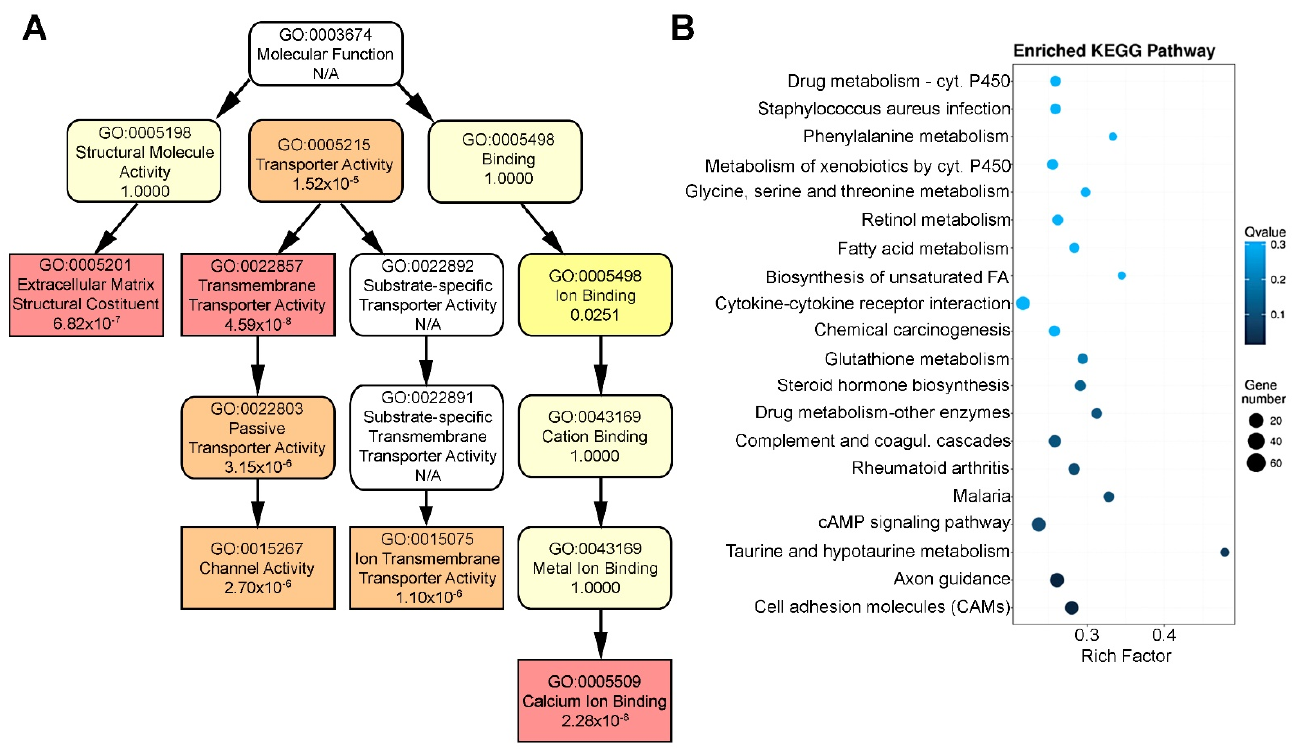
Figure 4. Gene Ontology and pathway analysis of DEGs. ( A ) GO functional enrichment of DEGs represented in the directed acyclic graph where each node shows the name of the GO term and the p -value. The darker (red) color corresponds to the lower p -value which indicates the more significant enrichment. ( B ) The top 20 functionally enriched KEGG pathways found in the analysis of DEGs in CTNS − / − vs. CTNS +/+ ciPTECs, in order of significance from bottom to top.